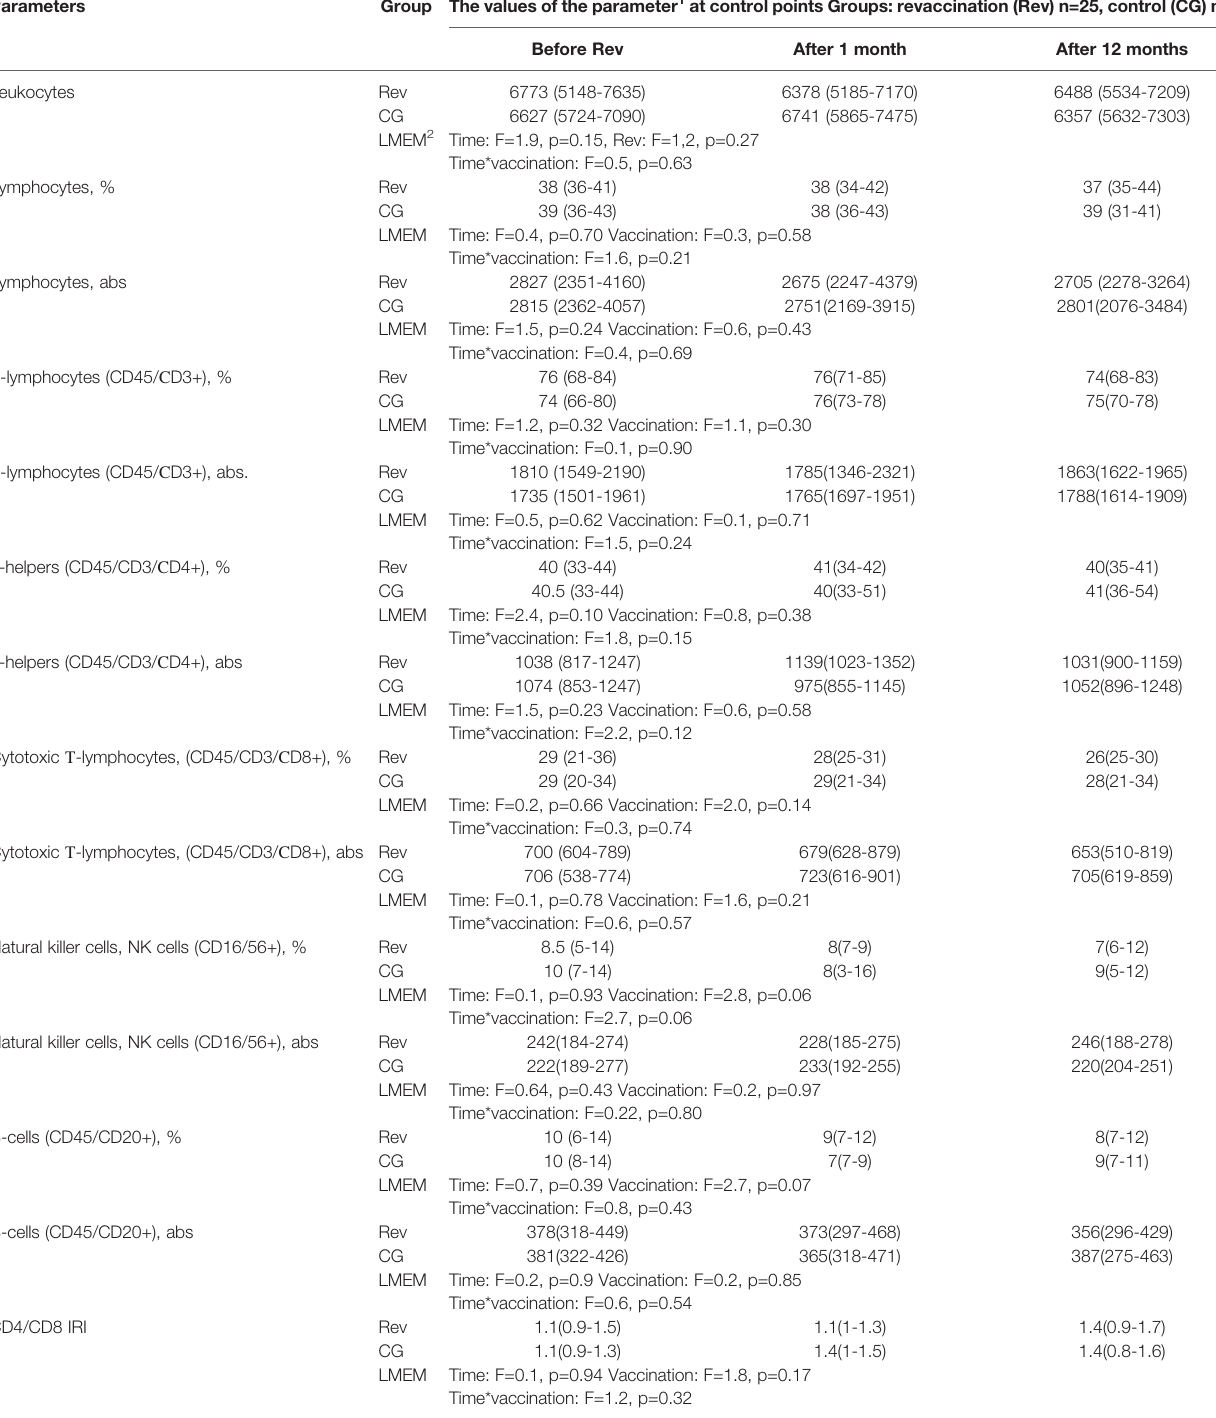
TABLE 3 | Dynamics of the subpopulation structure of peripheral blood lymphocytes in children with GN after revaccination with DT toxoid (n = 25) and in the control group (n = 20).